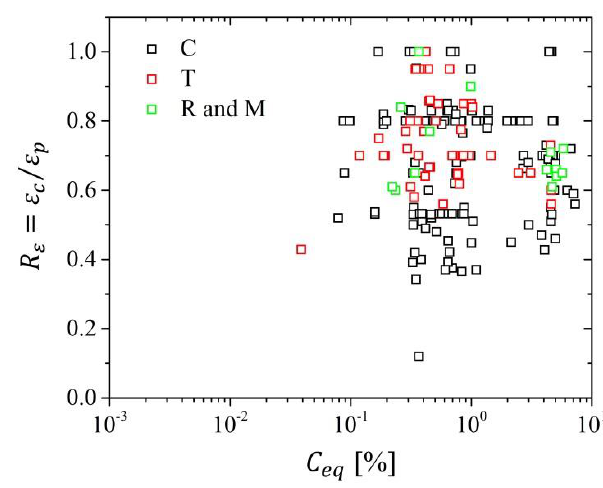
Figure 9. Critical strain ratio R ε vs. carbon equivalent of the alloys ( C eq ) using Equation (36).